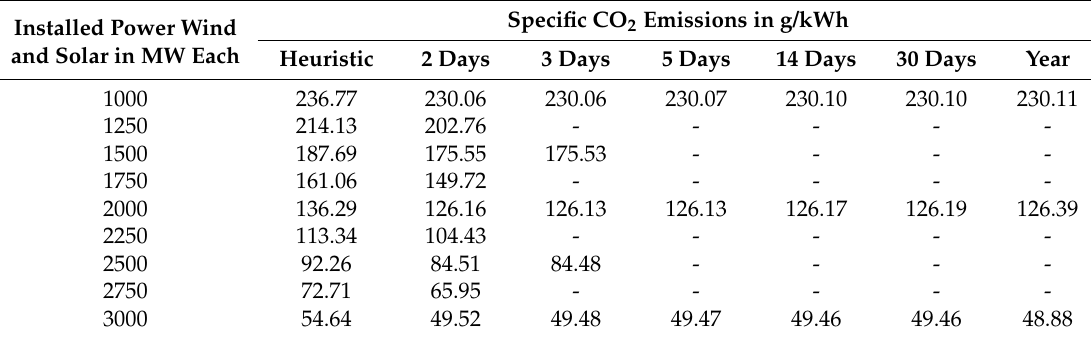
Table A3. Specific CO 2 emissions for simulated